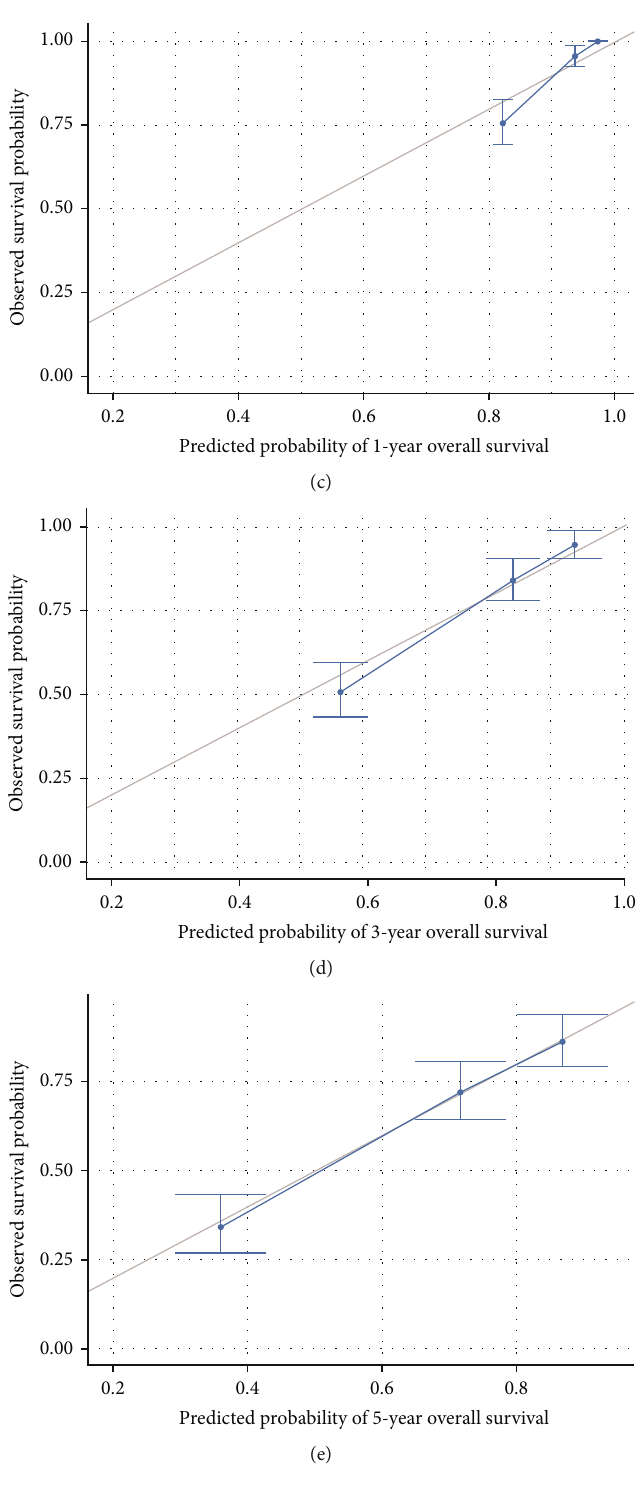
Figure 5: Establishment and assessment of the predictive nomogram. (a) Nomogram to predict the 1-, 3-, and 5-year OS of patients with clear cell renal cell carcinoma (ccRCC). (b) Relationship between the area under the curve (AUC) value and predicted survival time. Calibration curves veri fi ed the accuracy of the nomogram for predicting (c) 1-year overall survival, (d) 3-year overall survival, and (e) 5- year overall